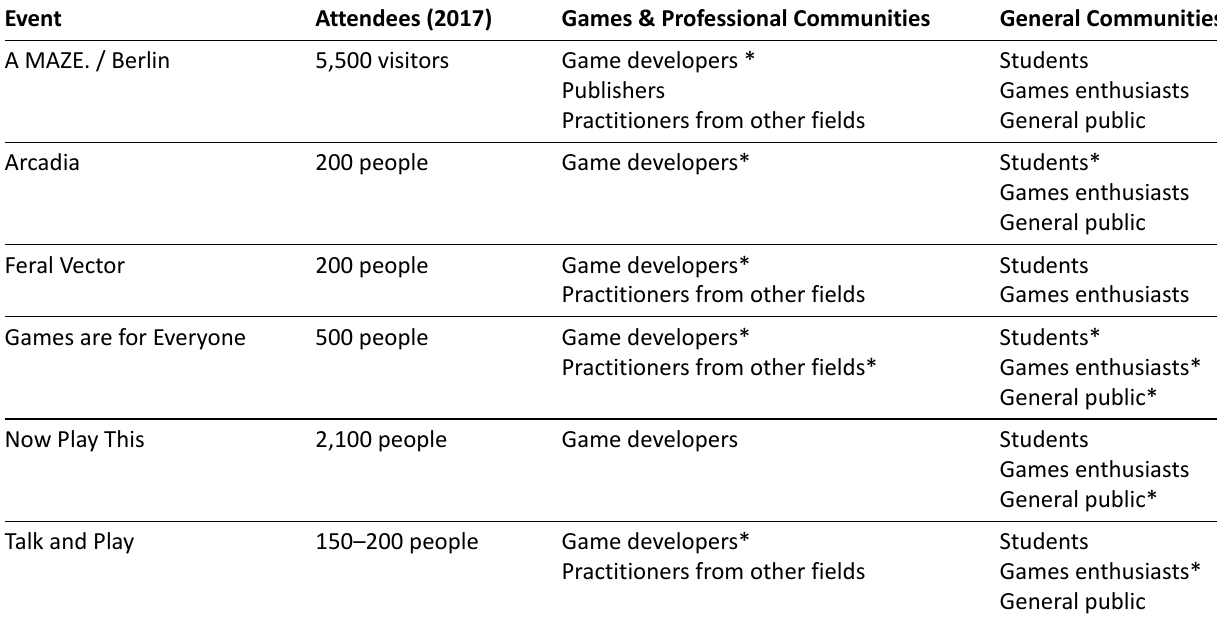
Table 2. Overview of audiences for each event.